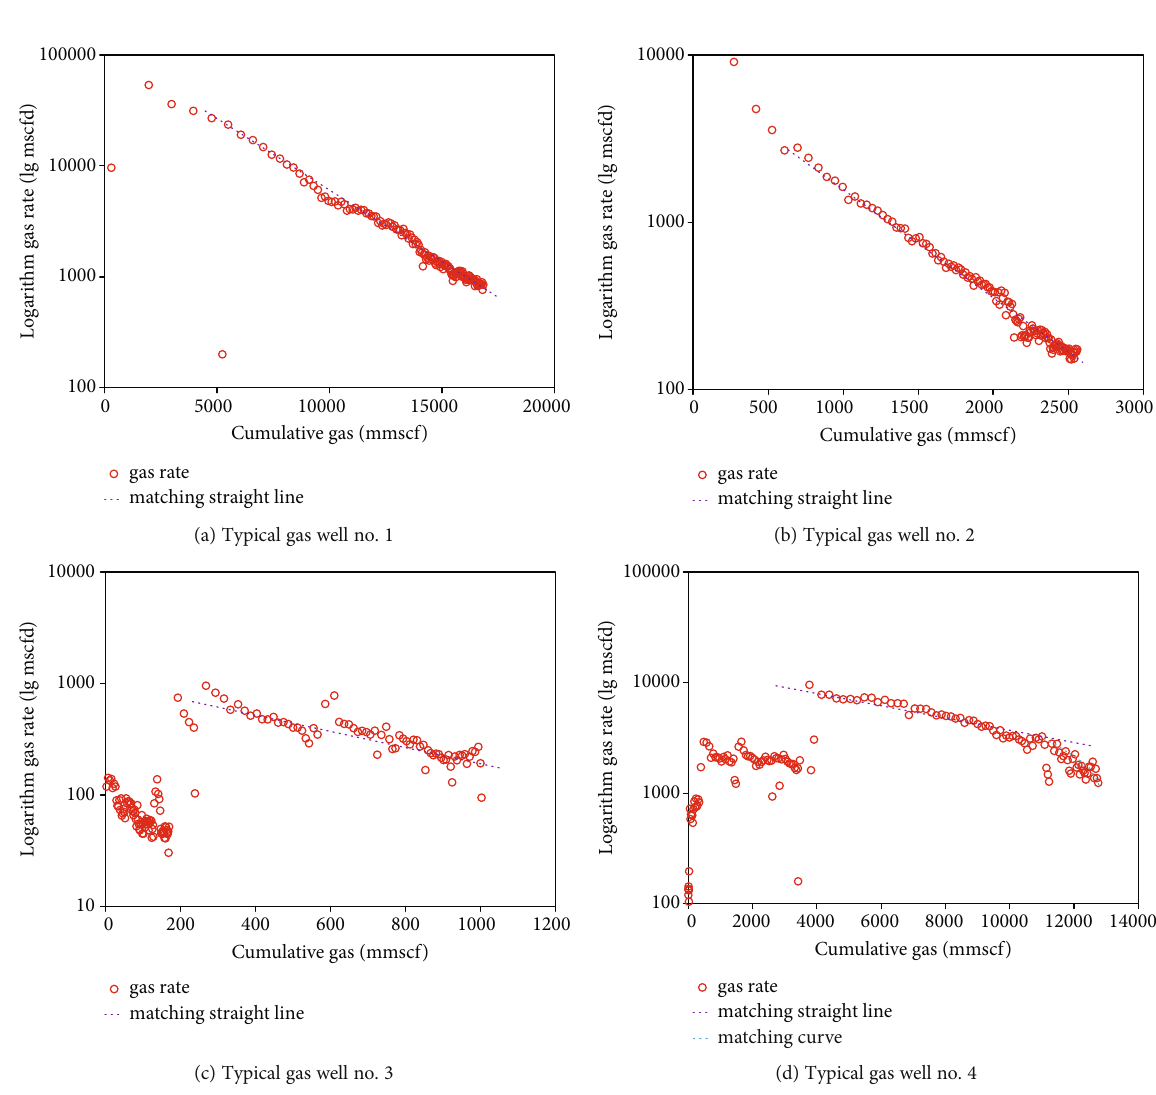
Figure 4: Typical production data of Barnett